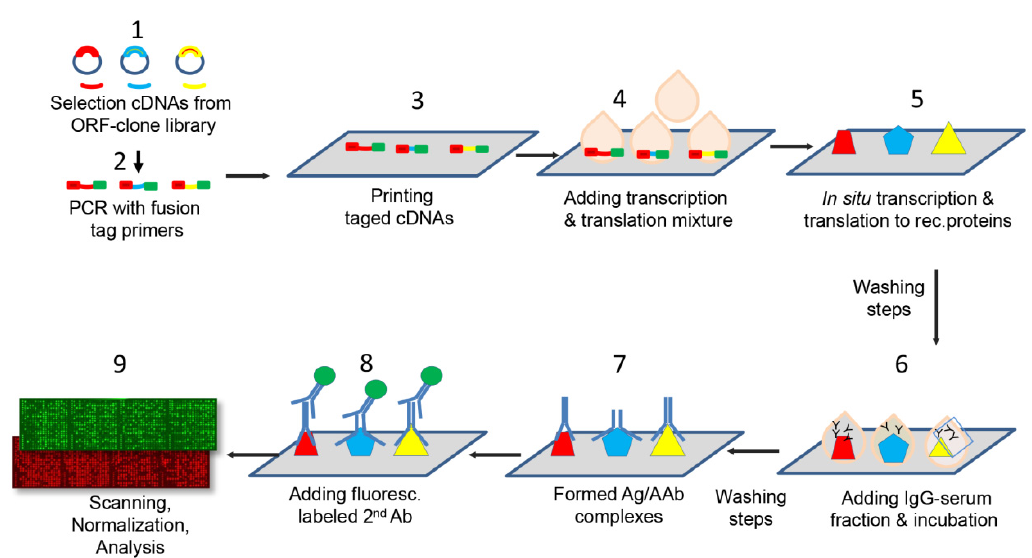
Figure 5. Simplified flow chart of the nine major steps for the manufacture of protein microarrays and their application for autoantibody detection and profiling. 1: cDNAs selection from library 2: Two-step PCR for enrichment cDNAs and fusion with tag primers. 3: Spotting of cDNAs on the epoxisilane-coated slides. 4: Addition of expression mixture to each DNA spot. 5: Incubation of the DNA / expression mixture for cell free transcription and translation. Removal of unbound proteins by washing. The recombinant proteins were retained through an epoxy-amino reaction. 6: Addition of IgG serum fractions and formation of antigen / antibody complexes. 7: Removal of unbound IgGs. 8: Incubation with fluorescence-conjugated secondary antibodies (anti-human IgG, IgM and IgA) directed against the primary antibodies from the patient sera. 9: Scanning of microarrays using a 635 nm laser (assessment of fluorescence intensity of each spot and normalization and microarray data analysis.